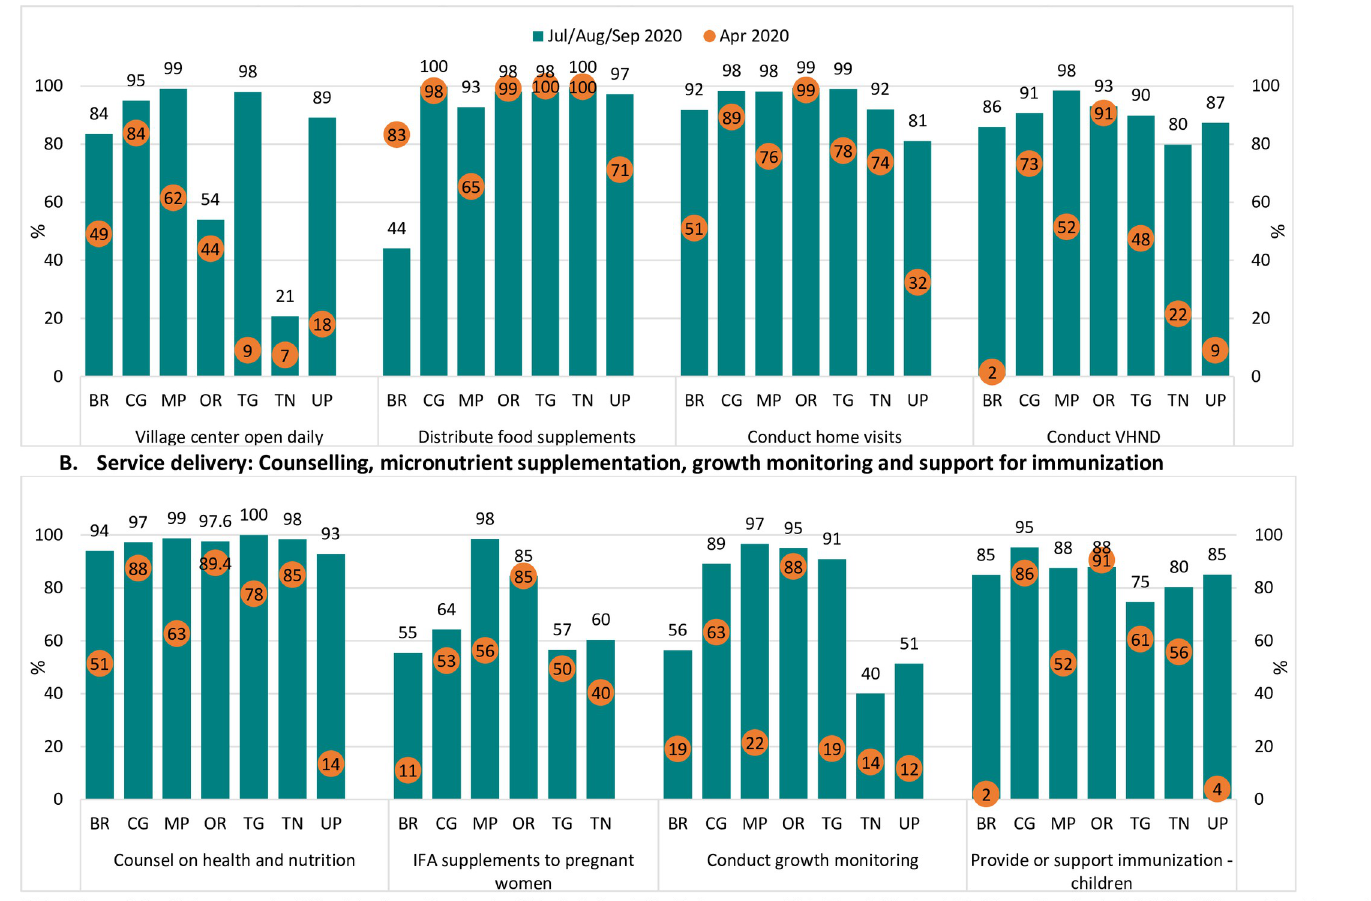
Fig 2. Anganwadi worker service delivery during the COVID lockdown in April 2020 and in July/August/September 2020, by state. A. Service delivery: Opening of village center, food supplementation, home visits, and conducting VHND. B. Service delivery: Counselling, micronutrient supplementation, growth monitoring and support for immunization. BR: Bihar, CG: Chhattisgarh; MP: Madhya Pradesh; OR: Odisha; TG: Telangana; TN: Tamil Nadu; UP: Uttar Pradesh; VHND: Village Health, and Nutrition Day, IFA: Iron-Folic Acid. Note: Anganwadi workers were not asked about distributing IFA supplements in Uttar Pradesh.